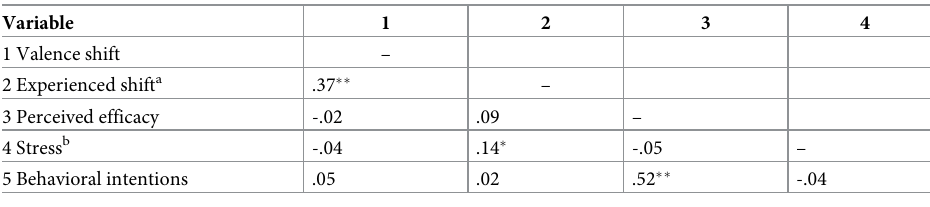
Table 1. Pearson zero-order